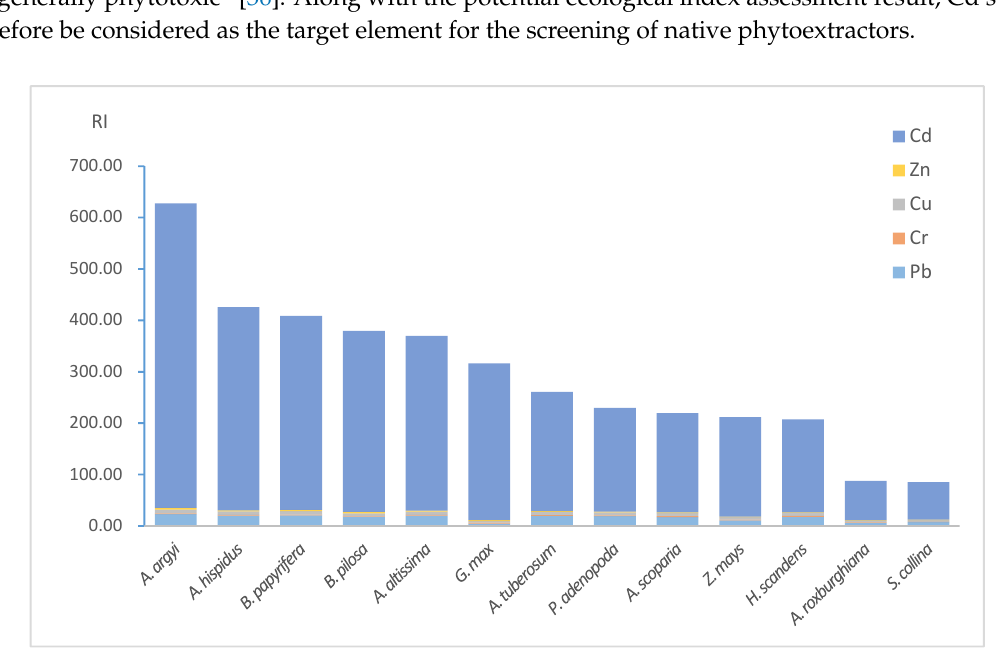
Figure 2. RI of the habitats of plant samples .